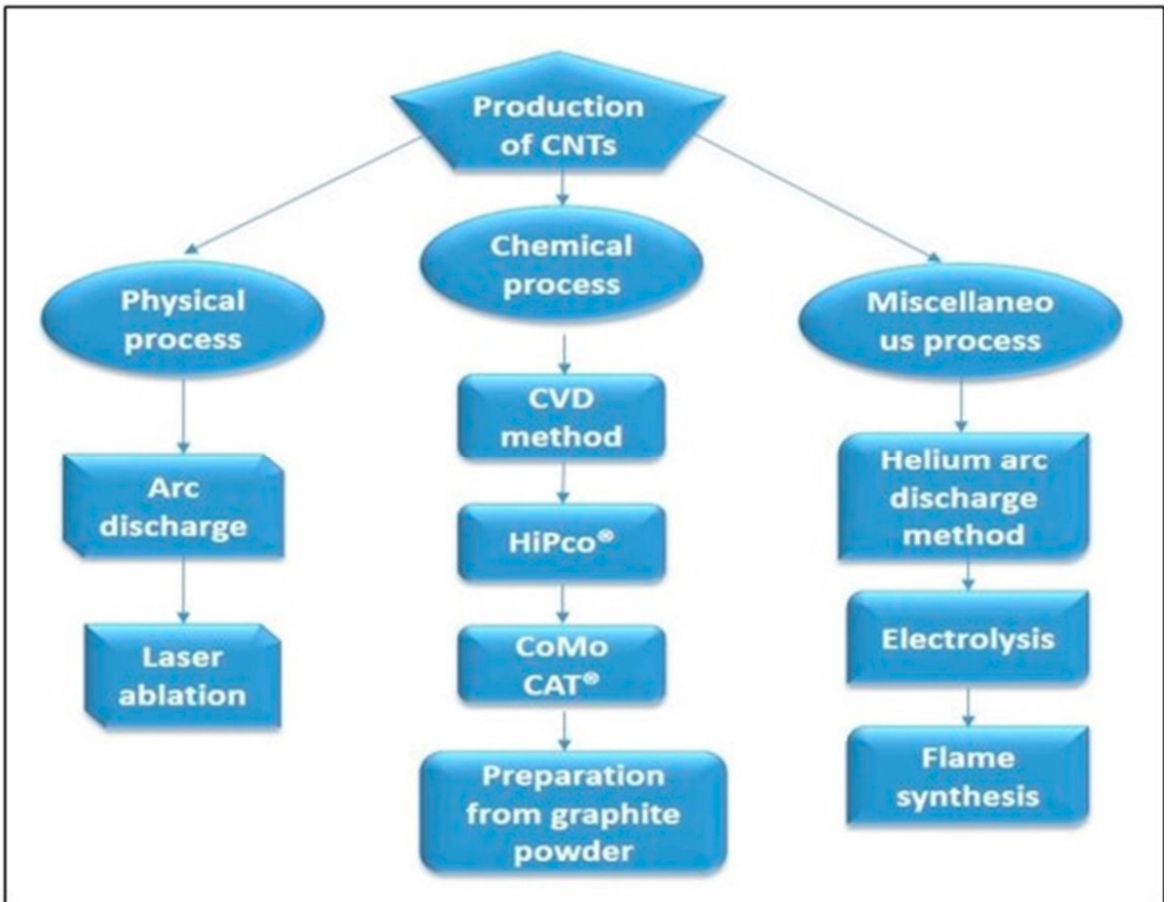
Figure 1. Production processes for carbon nanotubes (CNTs).